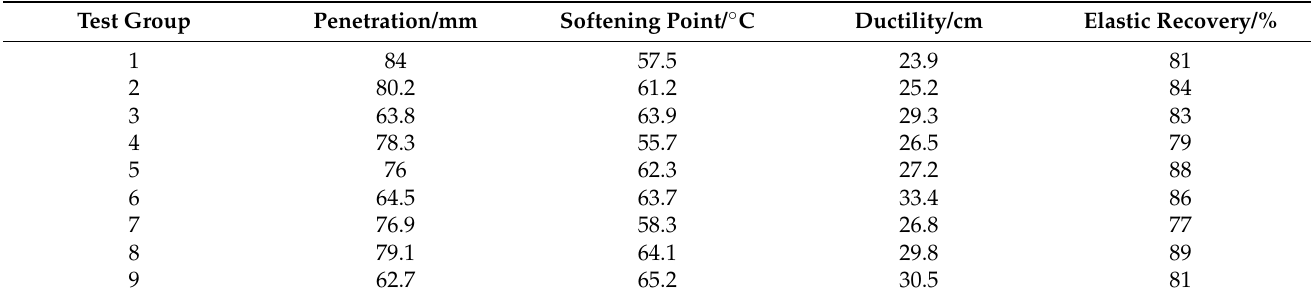
Table 5. Results of the orthogonal